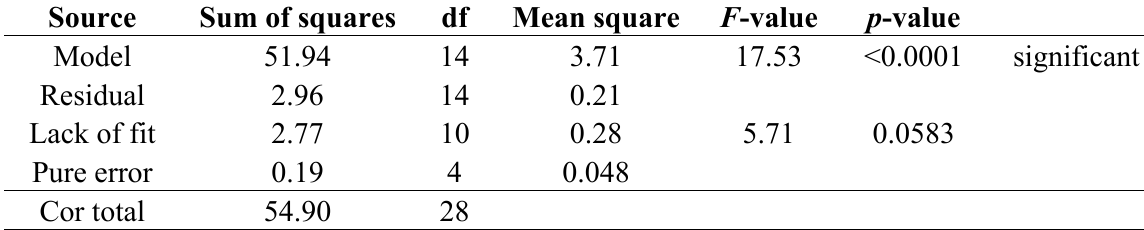
Table 3. Analysis of variance for fitted quadratic polynomial